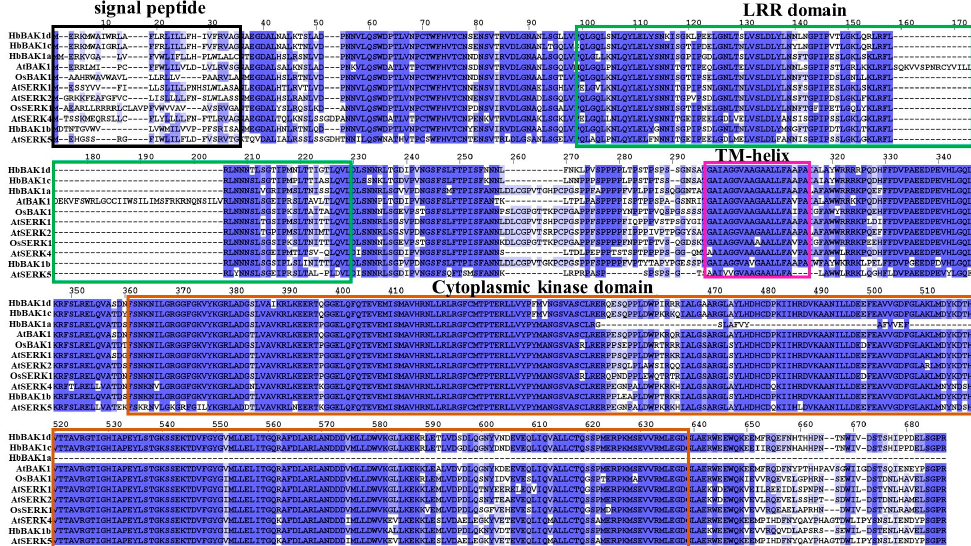
Figure 3. Multiple alignments of the HbBAK1 domains. Conserved domains of HbBAK1 amino acid sequences are marked in colored rectangles: signal peptide (black), LRR domain (green), transmem- brane domain (rose red) and serine/threonine kinase domain (brown).